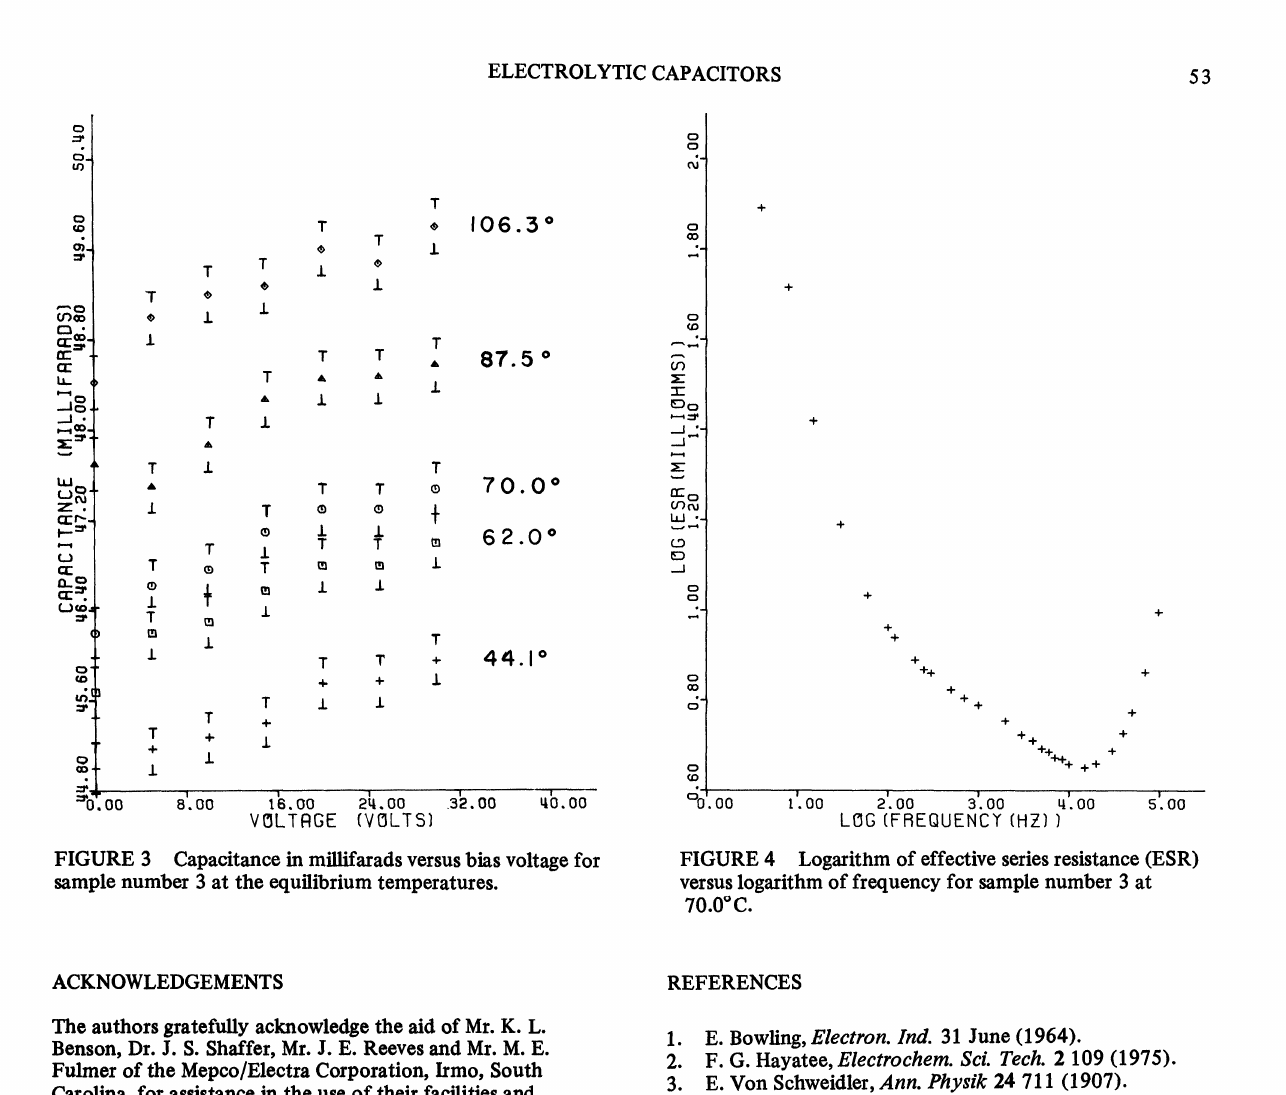
FIGURE 4 Logarithm of effective series resistance (ESR) versus logarithm of frequency for sample number 3 at